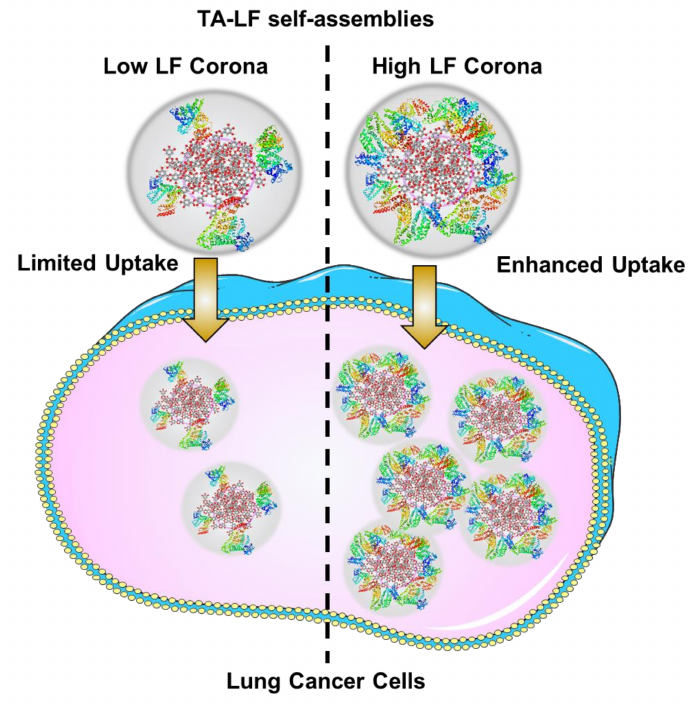
Figure 6. Schematic representation of LF corona influencing delivery of TA-LF assemblies to LC cells.